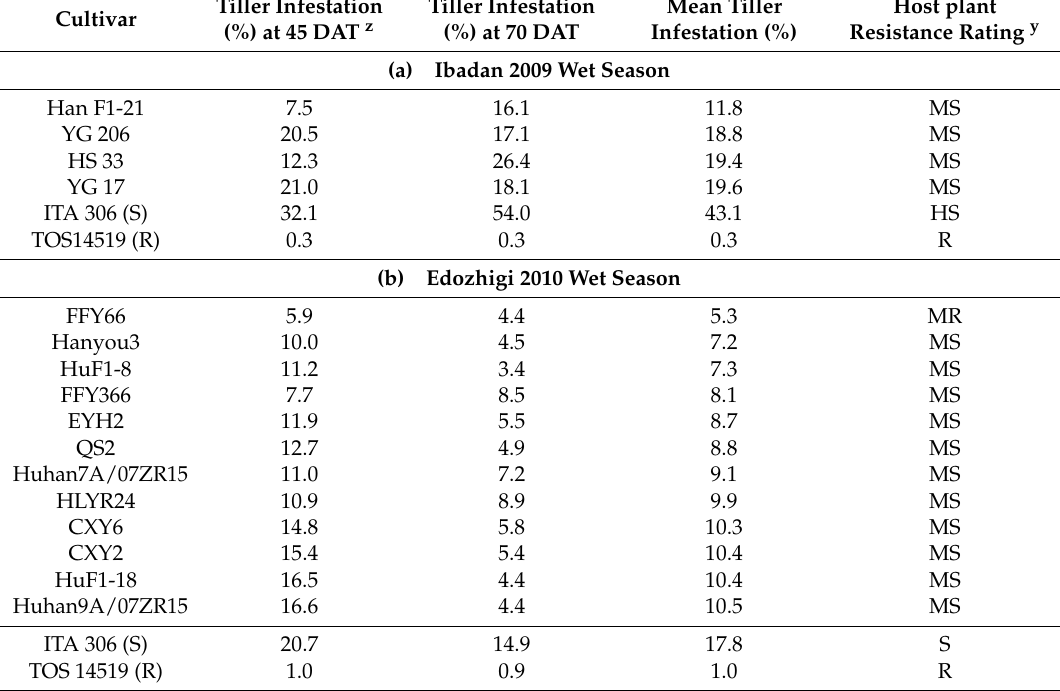
Table 6. Host plant resistance of most promising rice hybrids plus resistant and susceptible check cultivars to African rice gall midge after artificial infestation in screen house at ( a ) Ibadan 2009 wet season and ( b ) Edozhigi 2010 wet season.